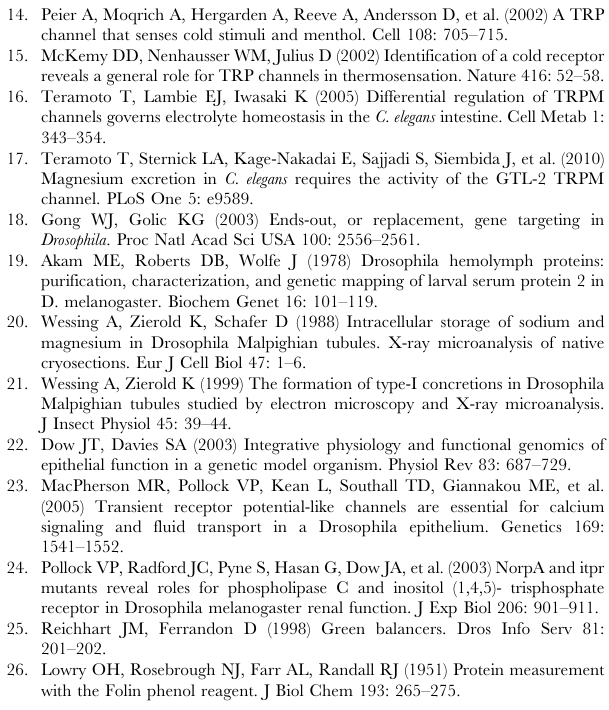
Figure S2 Representative fat bodies microdissected from trpm 2 , trpm 2 heterozygous and wild type (w1118) larvae that were either kept on medium containing 1 mM or 30 mM total magnesium, as indicated. The scale is the same in all